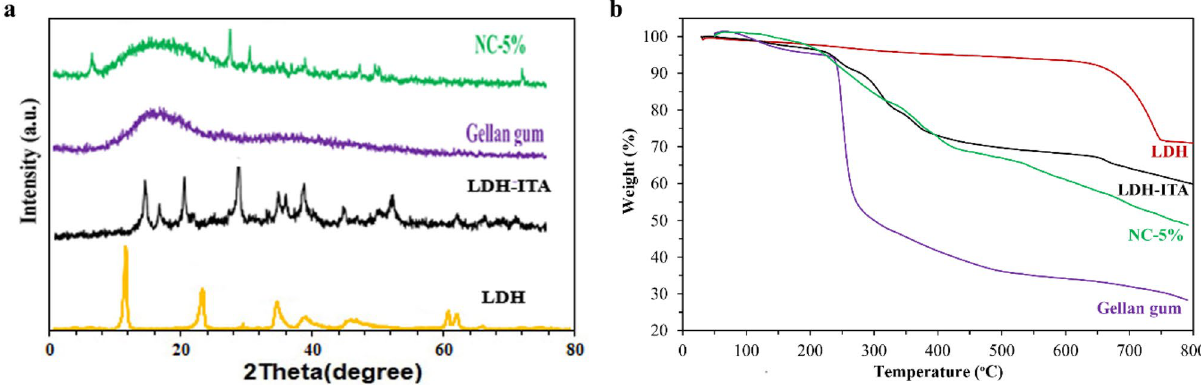
Figure 3. The XRD patterns ( a ) and the thermograms ( b ) of the prepared LDH, LDH-ITA, pure gellan gum, and